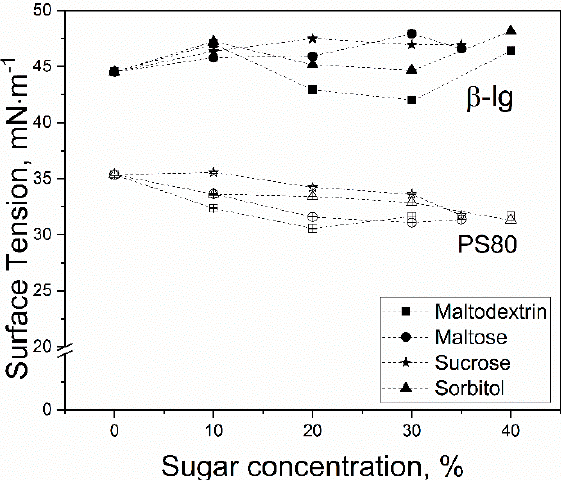
Figure 1. Surface tension of polysorbate 80 (empty symbols) and β -lactoglobulin (filled symbols) with different concentrations of added sugar after an equilibrium time of 7200 s at 20 °C, where ( ■ ) corresponds to maltodextrin, ( ● ) to maltose, ( ★ ) to sucrose, and ( ▲ ) to sorbitol, respectively. Table 2. Calculated surface activity of samples with polysorbate 80 and β -lactoglobulin in the presence of added saccha- rides with content between 0% and 30% at 20 °C